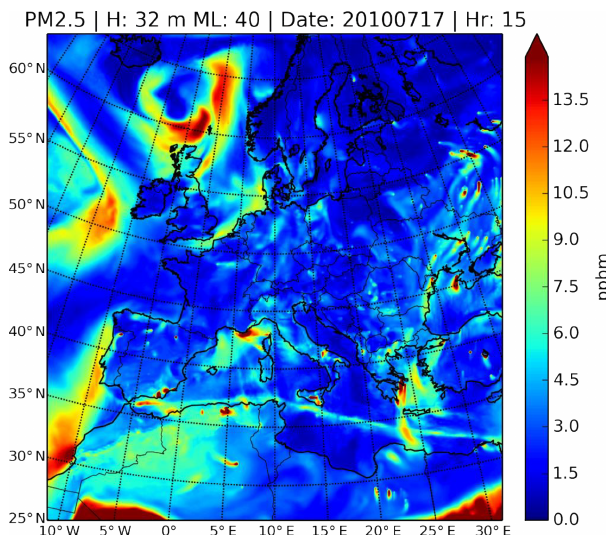
Figure 5. Example of the simulated PM 2 . 5 concentration over Eu- rope on 17 July 2010 with horizontal resolution of